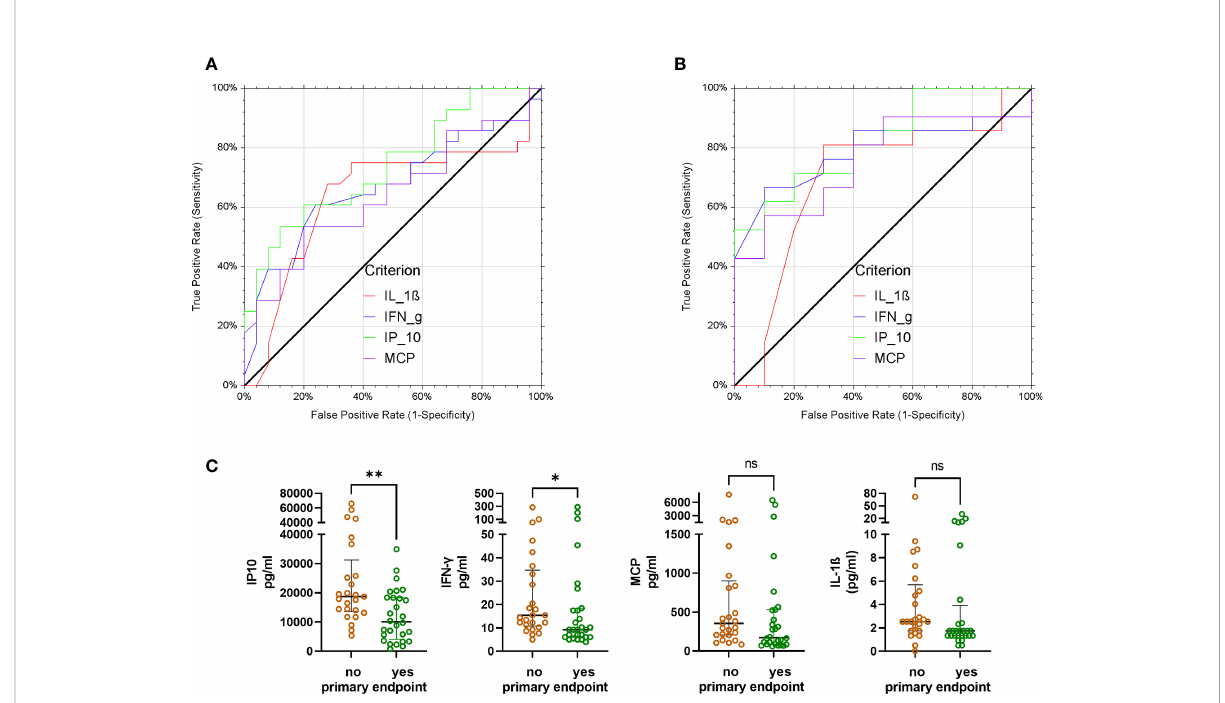
FIGURE 5 Receiver operating characteristics analysis of day 0 levels of IP-10, IFN- g , IL-1ß and MCP-1 and primary endpoint (failure versus success on day 21). Low levels of these cytokines on day 0 indicate a positive condition, i.e. patients reached the primary endpoint. (A) All patients (irrespective of allocation to randomization group). Area under the curve (AUC) and p-values for AUC >0.5 were as follows: IP-10: AUC 0.74; p=0.0002; IFN- g : AUC 0.67, p=0.013; MCP-1: AUC 0.64, p=0.03; IL-1ß: AUC 0.64, p=0.04). (B) Patients in the CCP group Area under the curve (AUC) and p- values for AUC >0.5 were as follows: IP-10: AUC 0.82; p<0.0001; IFN- g : AUC 0.79, p=0.0002; MCP-1: AUC 0.76, p=0.002; IL-1ß: AUC 0.70, p=0.04). (C) Comparison of day 0 levels of IP-10, IFN- g , MCP-1 and IL-1ß (from left to right) between patients not reaching the primary endpoint (brown symbols) or reaching the primary endpoint on day 21 (green symbols). Groups were compared by Mann-Whitney test. *p<0.05, **p<0.01, ***p<0.001,